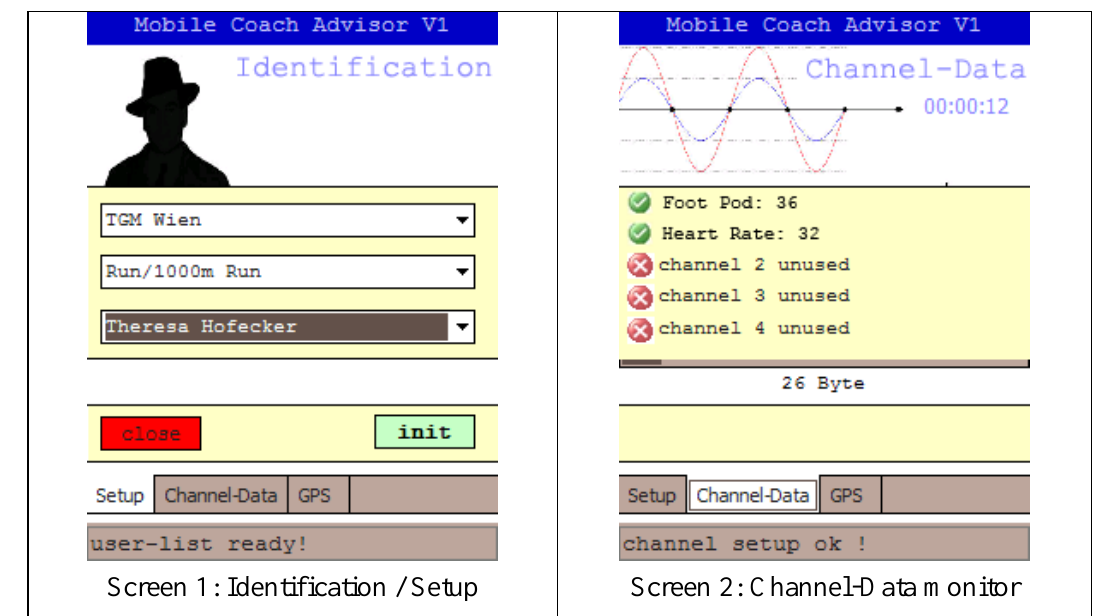
Figure 6. GUI of the A-Client